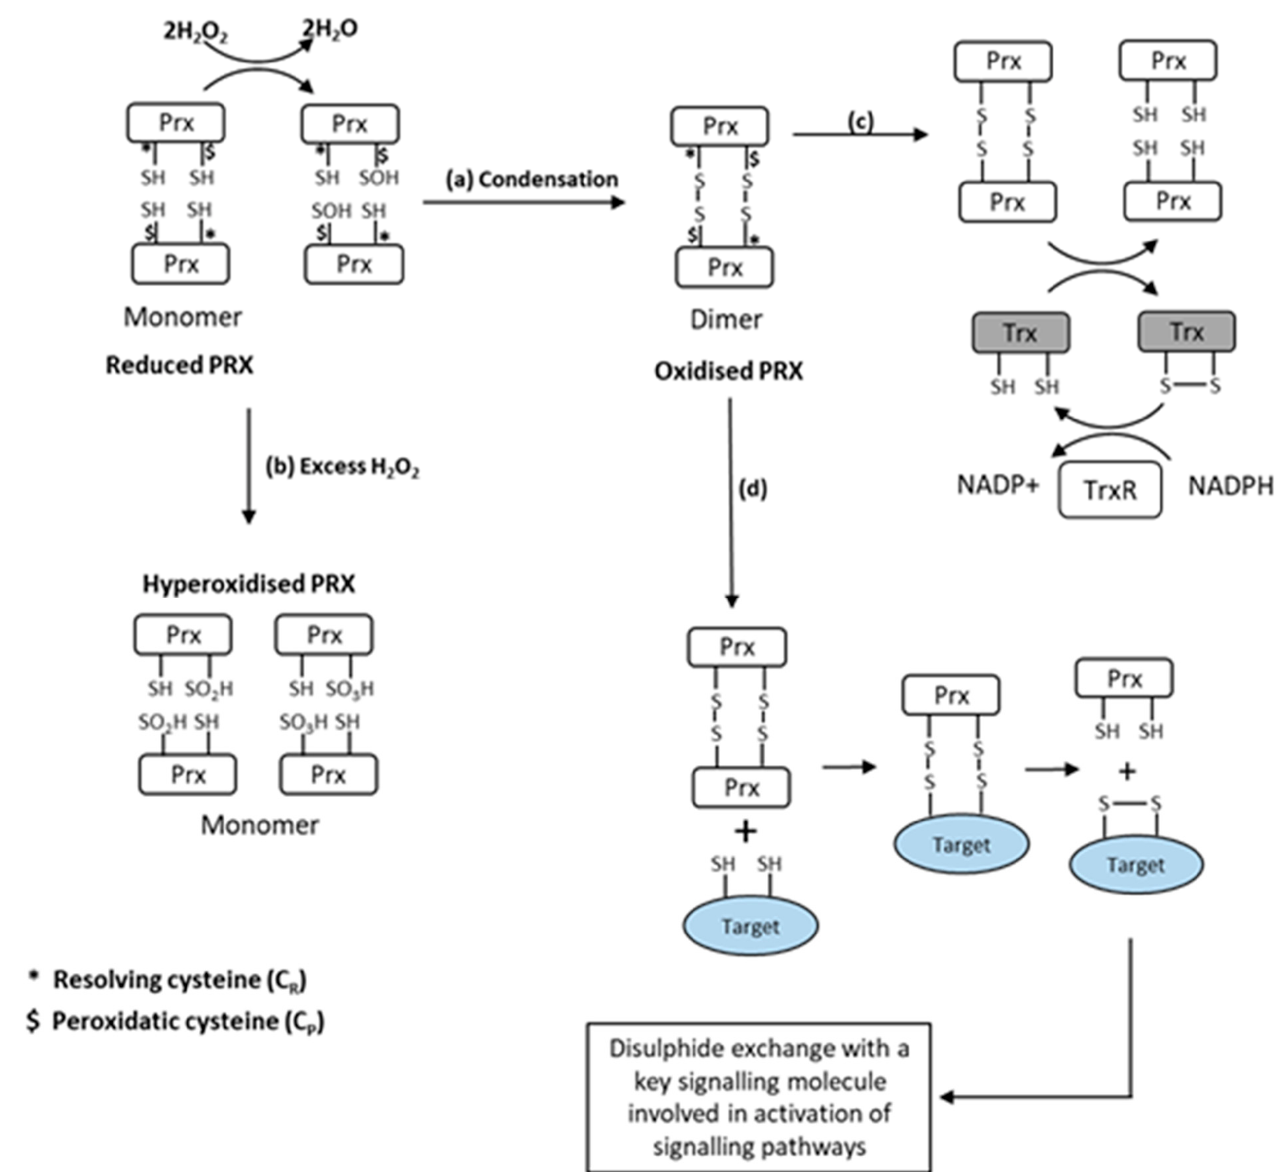
Figure 2. Schematic representation of the oxidation of 2-Cys Prx by H 2 O 2 . ( a ) Initial oxidation of Prx peroxidatic cysteine to form sulfenic acid with condensation to form Prx homodimers. ( b ) With further oxidation by H 2 O 2 , sulfinic or sulphonic acids are formed, which cannot form dimers (a process called hyperoxidation). ( c ) Dimerised Prx can be reduced by thioredoxin (Trx) at the expense of NADPH. ( d ) Dimerised Prx can also interact with reduced Cys in other proteins (indicated in grey), forming mixed dimers with transfer of oxidizing equivalents to the target protein from [64].